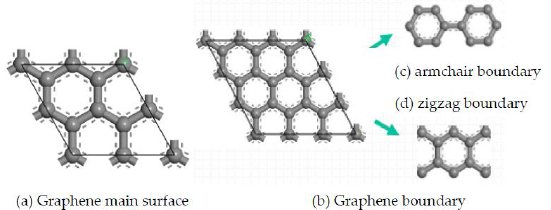
Figure 4. Intrinsic graphene.